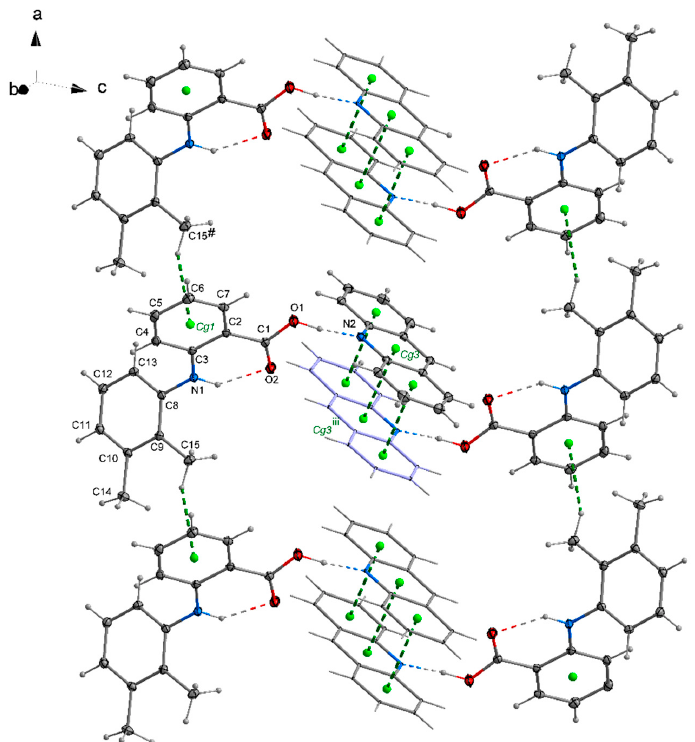
Figure 3. Arrangement of mefenamic acid and acridine molecules in 2 forming a double chain stretching along the [100] direction. Stacking of acridine molecules and C–H … π interactions between mefenamic acid molecules (Table S1, Supplementary Materials) are shown by green dashed lines linking centers of aromatic rings (centroids of rings-Cg-marked as green balls; Cg1 (C2/C3/C4/C5/C6/C7), Cg3 (N2/C21/C26/C27/C28/C33)) Symmetry codes: # = 1 + x, y, z; iii = − x + 1, − y, − z + 1.